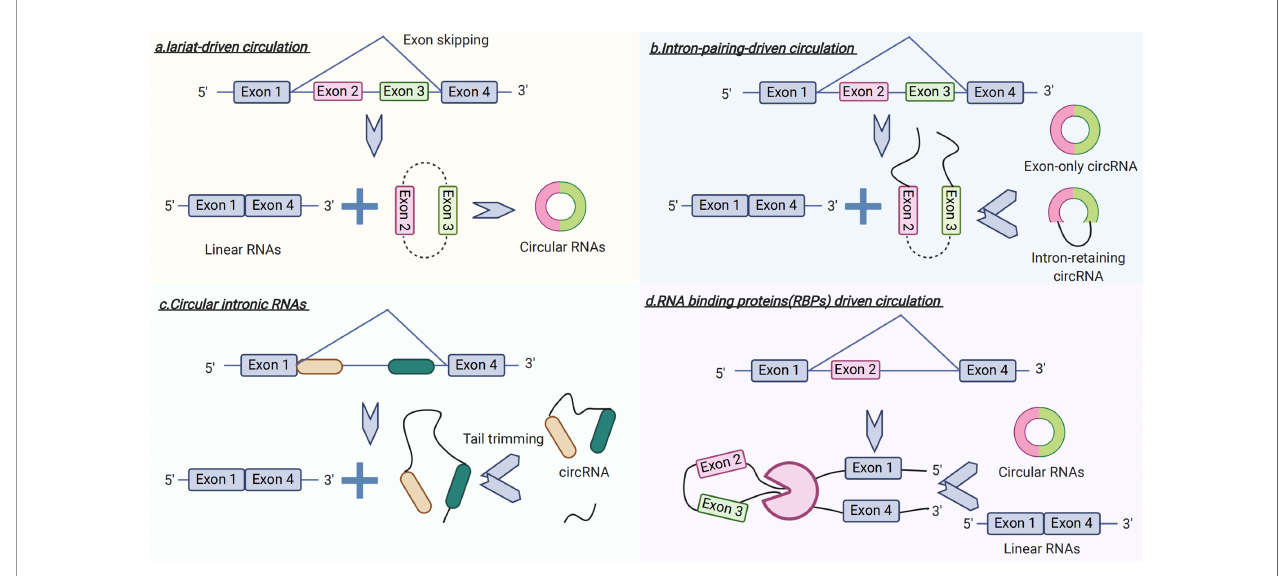
FIGURE 3 | Circular RNA (circRNA)